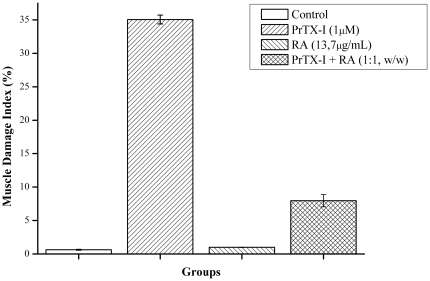
Effect of RA upon the muscle damage index induced by PrTX-I in mouse diaphragm preparations.The ordinate represents the % of damaged fibers relative to normal fibers and the abscissa indicates the experimental groups. The bars are expressed as mean ± S.E.